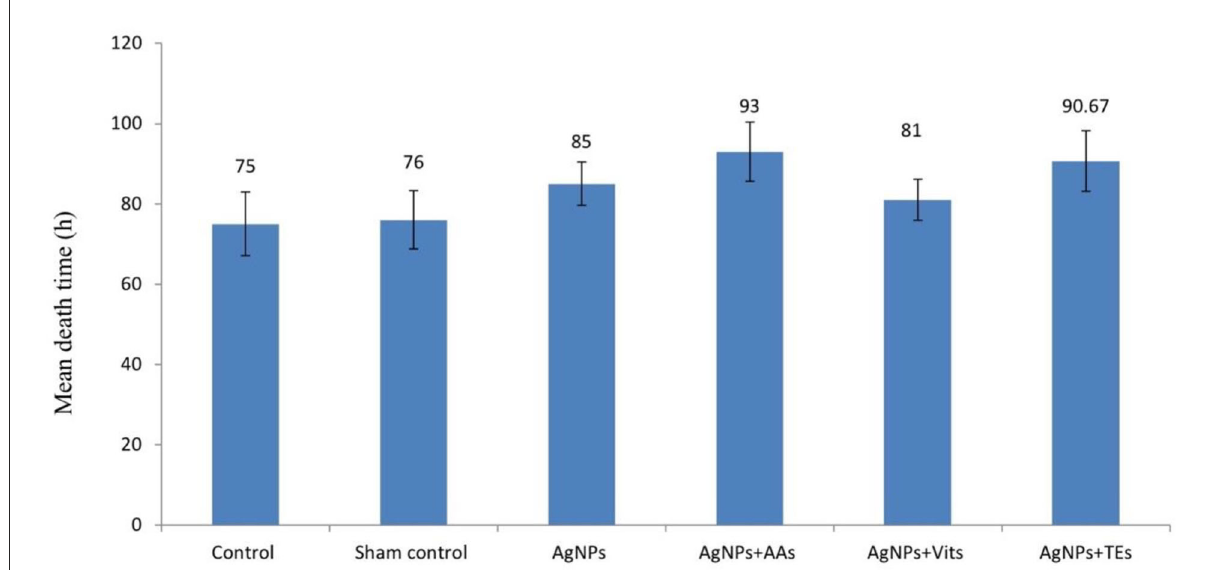
FIGURE1 Effect of in ovo administration of silver nanoparticles (AgNPs) and critical nutrients on mean death time (h) of virulent ND virus (vNDV) challenged birds in unvaccinated group. Control = un-injected, sham (sterile water), AgNPs = silver nanoparticles (50 µ g), AgNPs + AAs = silver